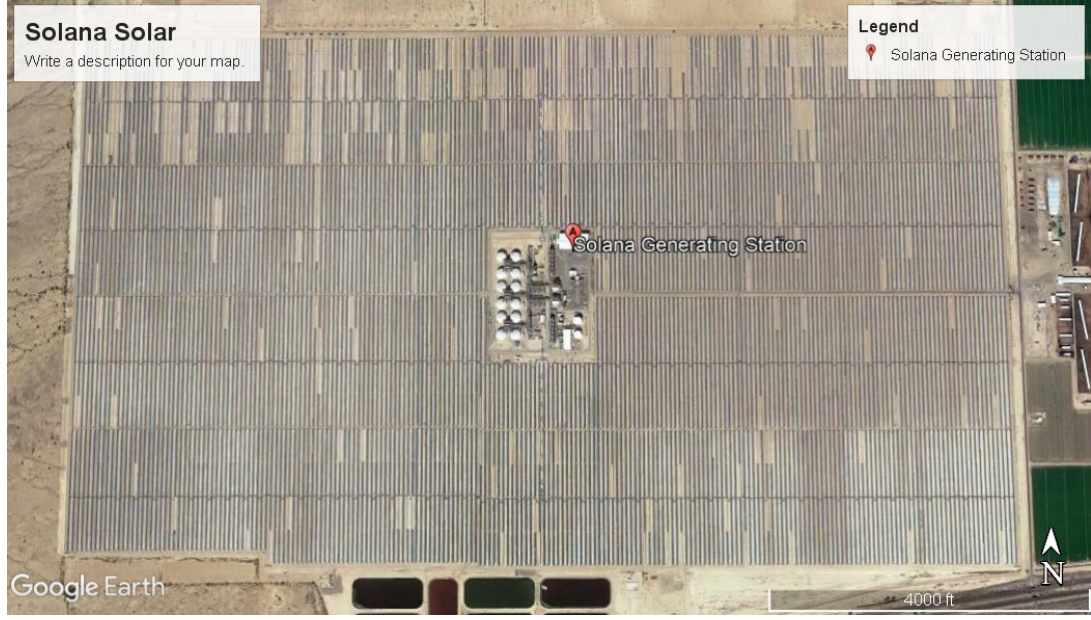
Figure 6. Google Earth view of Solana solar energy project. Map data ©2020 Google.